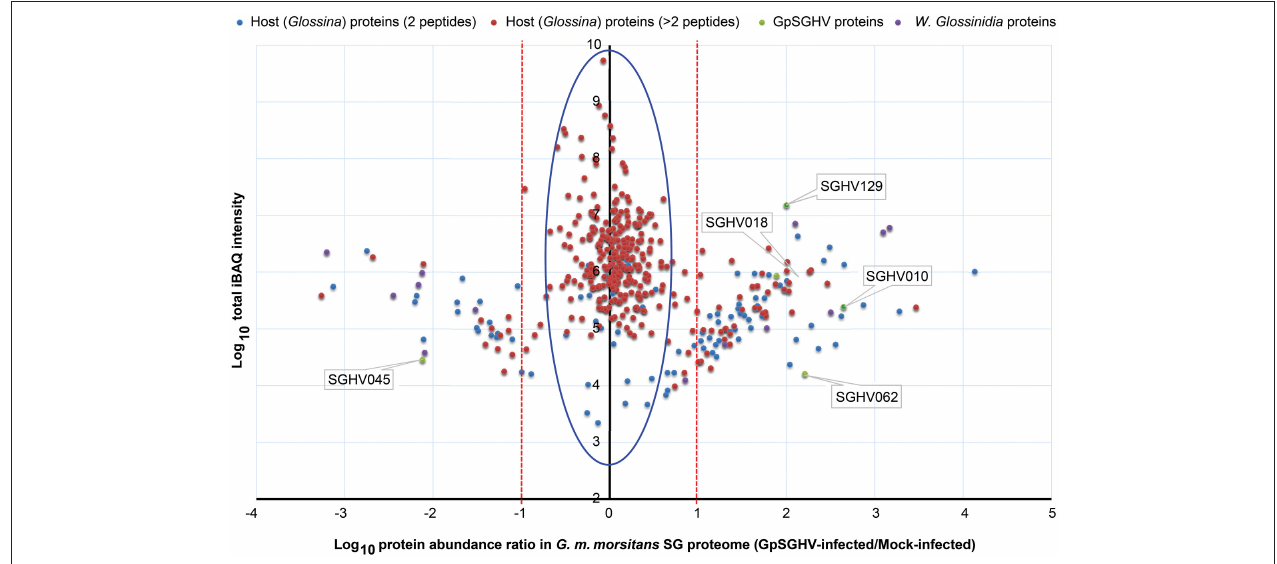
FIGURE 2 | Abundance distribution ratios of G. m. morsitans SG proteins. The figure depicts the distribution of proteins detected in the SG proteome of G. m. morsitans infected by GpSGHV compared to the mock-infected controls. Shown are the host proteins that were detected by two (light blue) or more (red) peptides per protein. GpSGHV and Wigglesworthia glossinidia proteins are shown in green and purple, respectively. The proteins that were up-regulated and down-regulated in GpSGHV-infected SG are shown on the right and left sides of the Y-axis, respectively (in the blue large circle). The dotted red lines represent 10-fold protein regulation. iBAQ denotes intensity-based absolute